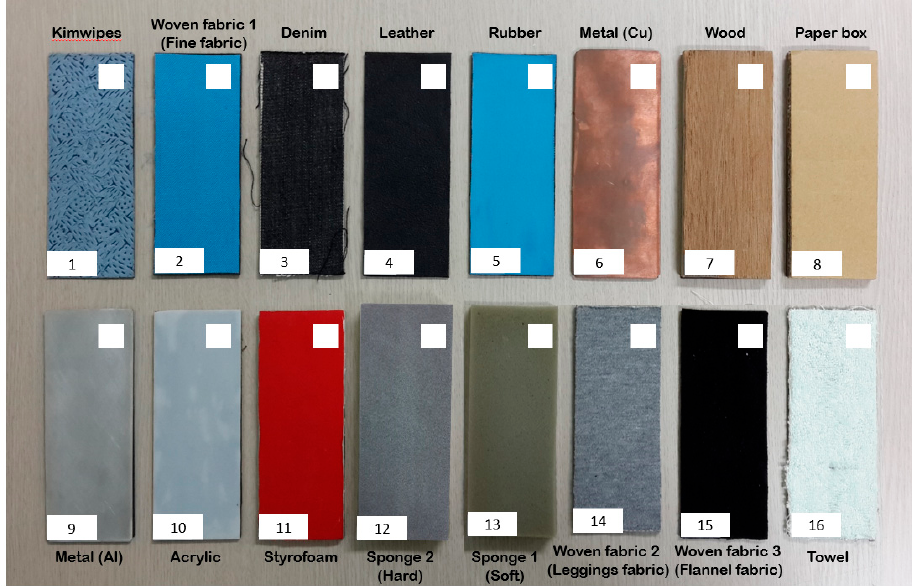
Figure 5. The picture of 16 tactile samples used in the tactile identification experiment.